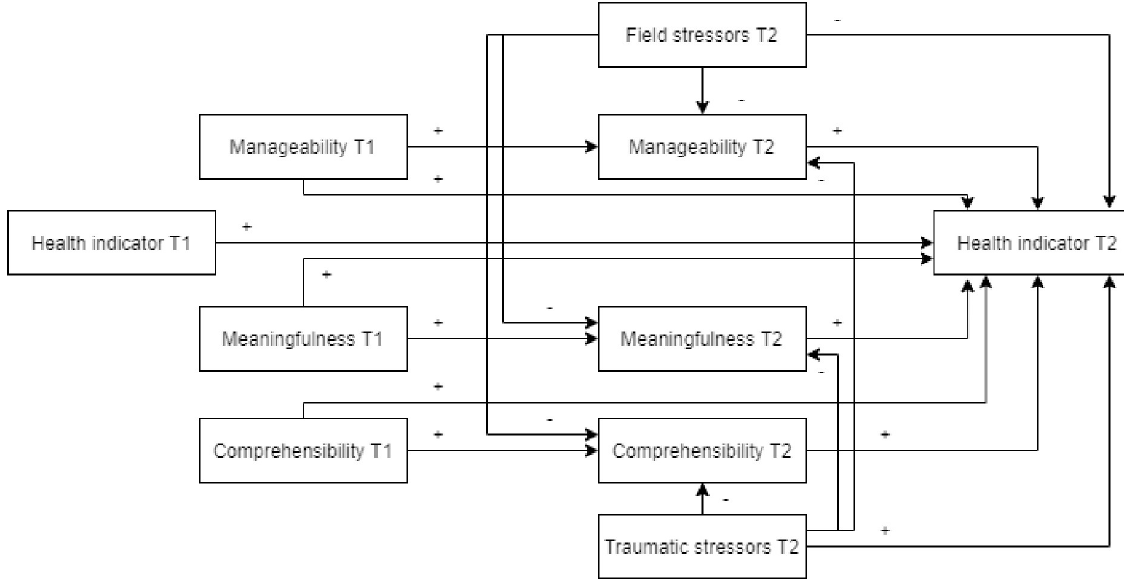
Fig 1. Hypothesized model about the relationship between the health outcome and its predictors. A plus sign denotes a positive/beneficial association; a negative sign denotes a detrimental association.